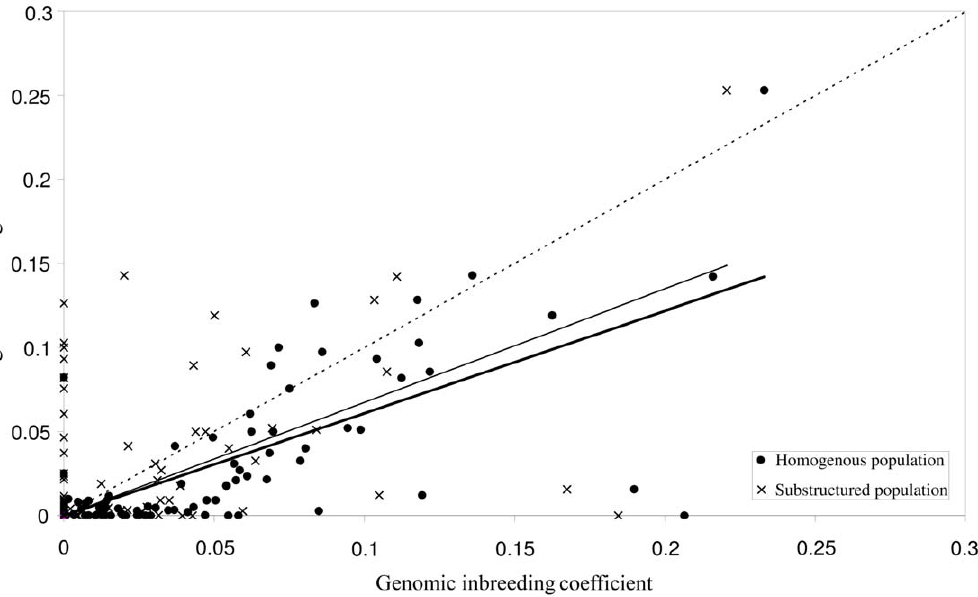
Figure 5. Inbreeding coefficients based on the genomic data ( F SNP ) assuming either a substructured or homogenous populations, plotted against inbreeding coefficients based on the pedigree data ( F PED ). The dash line follows the expectation that inbreeding coefficients are the same when using genomic and pedigree data; the thin-grey and bold-black lines indicate the linear regressions in assuming a substructured population or homogenous population, respectively.